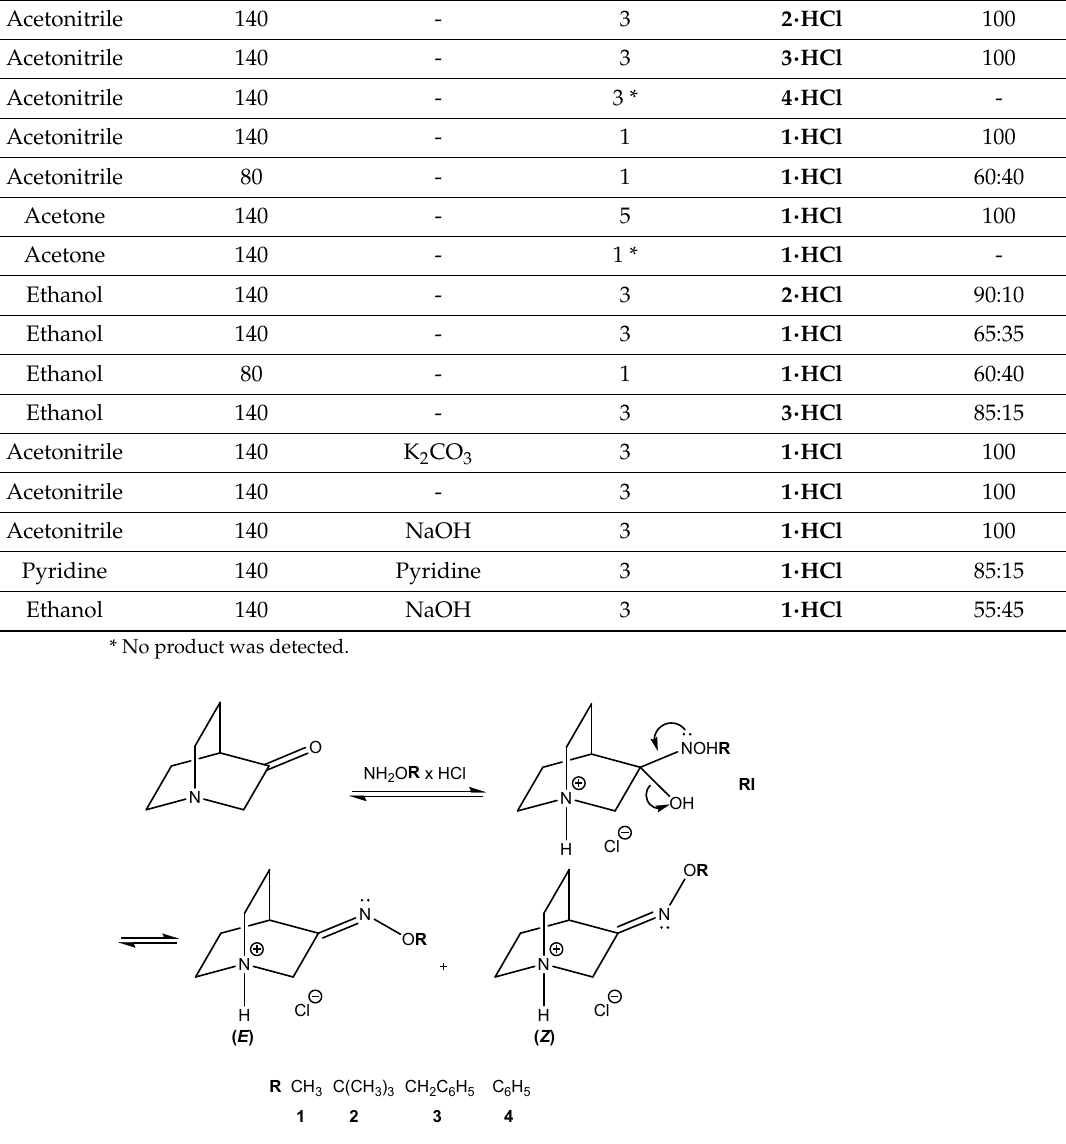
Figure 5. Proposed mechanism of the studied reaction for the synthesis of O -substituted quinuclidin- 3-one oximes ( 1 – 4